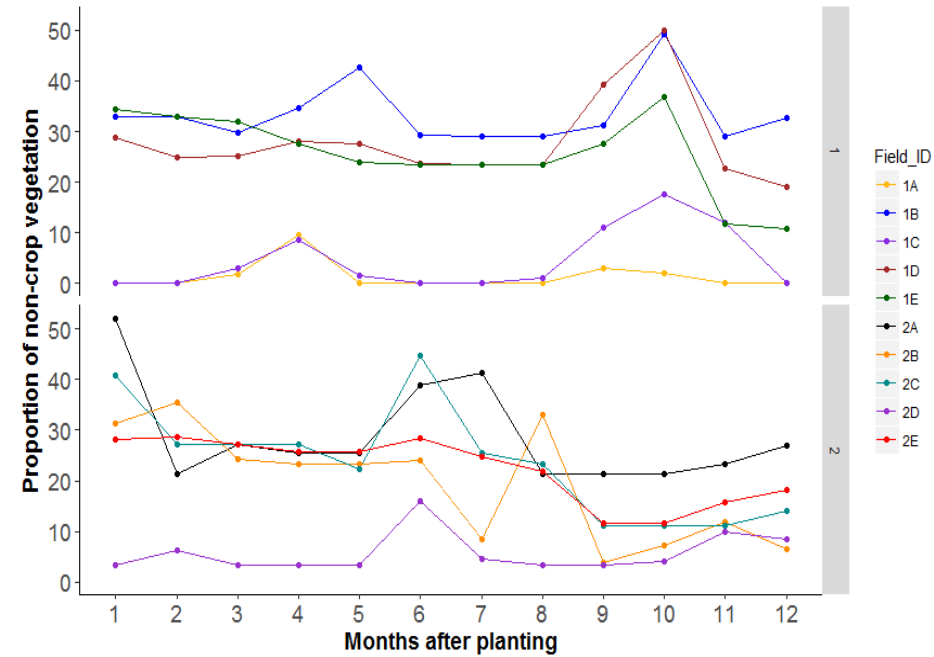
Figure 7. Change in non-crop (native vegetation) areas across time.